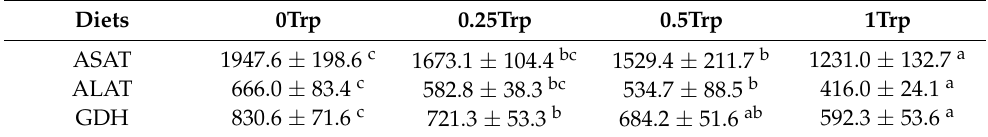
Table 6. Hepatic activity of aspartate aminotransferase (ASAT), alanine aminotransferase (ALAT), and glutamate dehydrogenase (GDH) enzymes of meagre juveniles fed the experimental diets. Diets 0Trp 0.25Trp 0.5Trp 1Trp ASAT 1947.6 ± 198.6 c 1673.1 ± 104.4 bc 1529.4 ± 211.7 b 1231.0 ± 132.7 a ALAT 666.0 ± 83.4 c 582.8 ± 38.3 bc 534.7 ± 88.5 b 416.0 ± 24.1 a GDH 830.6 ± 71.6 c 721.3 ± 53.3 b 684.2 ± 51.6 ab 592.3 ± 53.6 a Mean values ± SD (n = 6) in the same row with different superscript letters are significantly different ( p < 0.05). Units for all activities are presented as nmol/min/mg